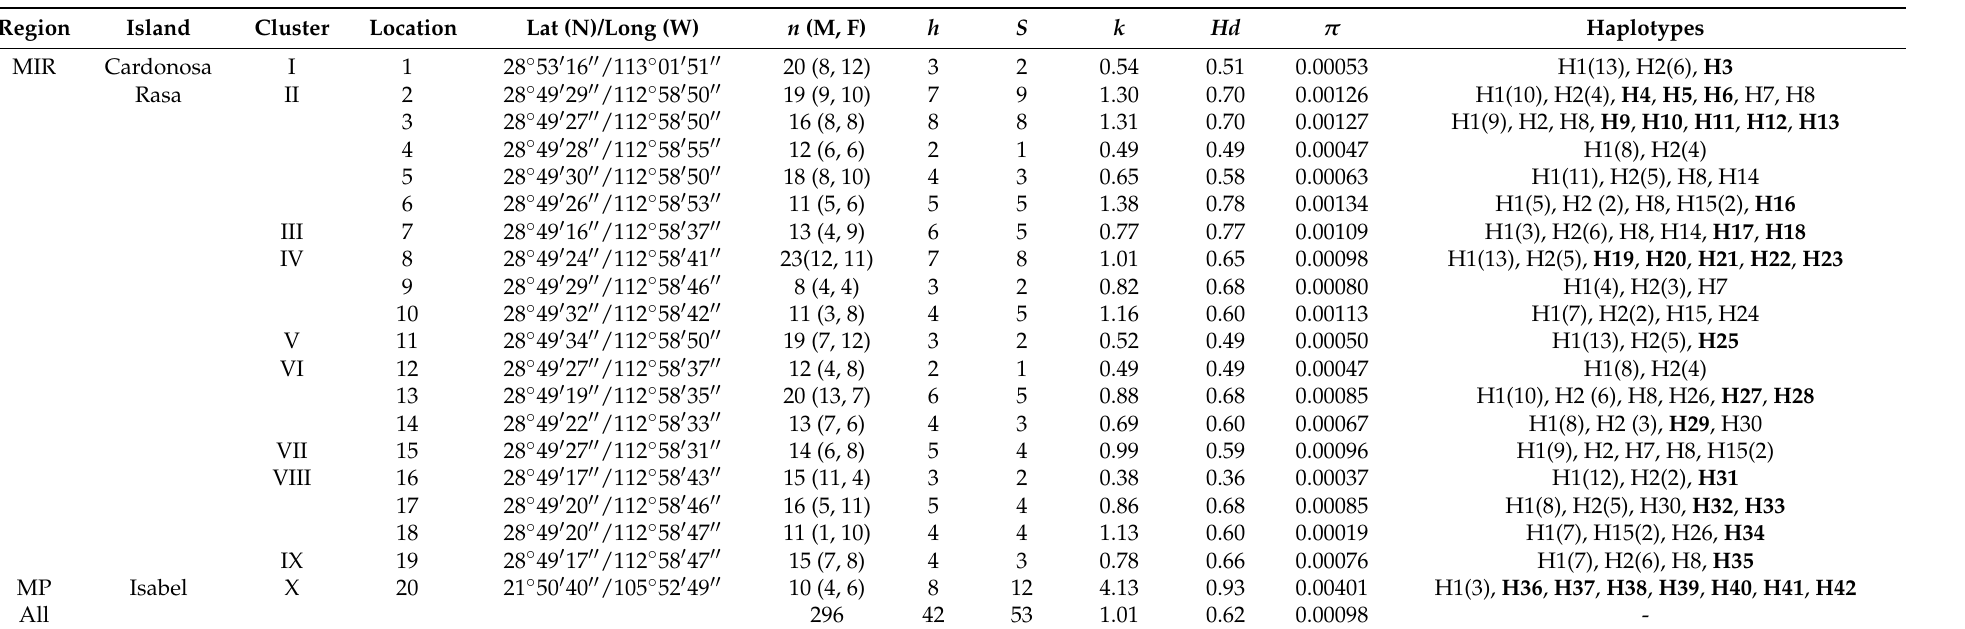
Table 3. Nucleotide polymorphism for cytochrome b sequences ( n = 296) of Heermann’s Gulls breeding in Cardonosa, Rasa, and Isabel Island, within the biogeographic regions Midriff Islands Region (MIR) and Mexican Province (MP). Coordinates of each location with the number of males (M = 132) and females (F = 164) sampled, respectively, are shown. Forty-two haplotypes were recovered (H1 to H42). The number of gulls for each haplotype is next, in brackets. Unique haplotypes are shown in